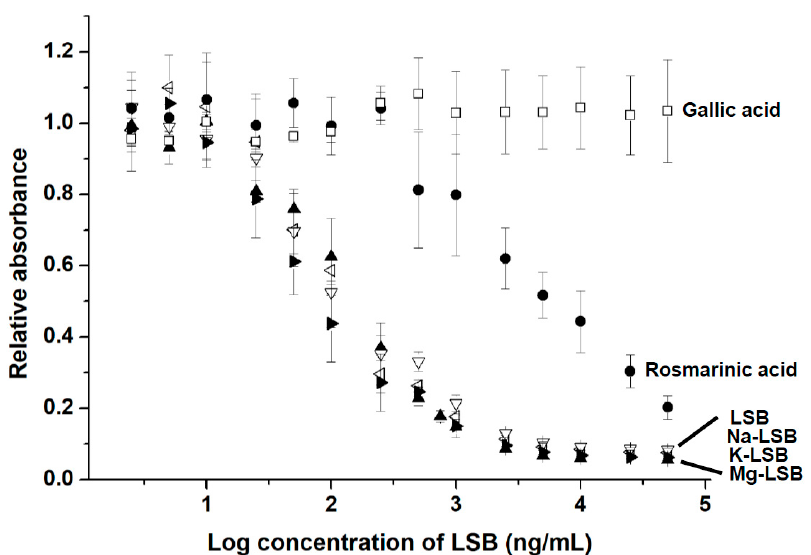
Figure 4. Cross-reactive curves for the detection of several phenolic compounds by indirect competitive ELISA with Ab-LSB. Each point of the curve presents the mean ± SD (replicate, n = 3). Na-LSB = sodium lithospermate; K-LSB = potassium lithospermate; Mg-LSB = magnesium lithoserpmate.